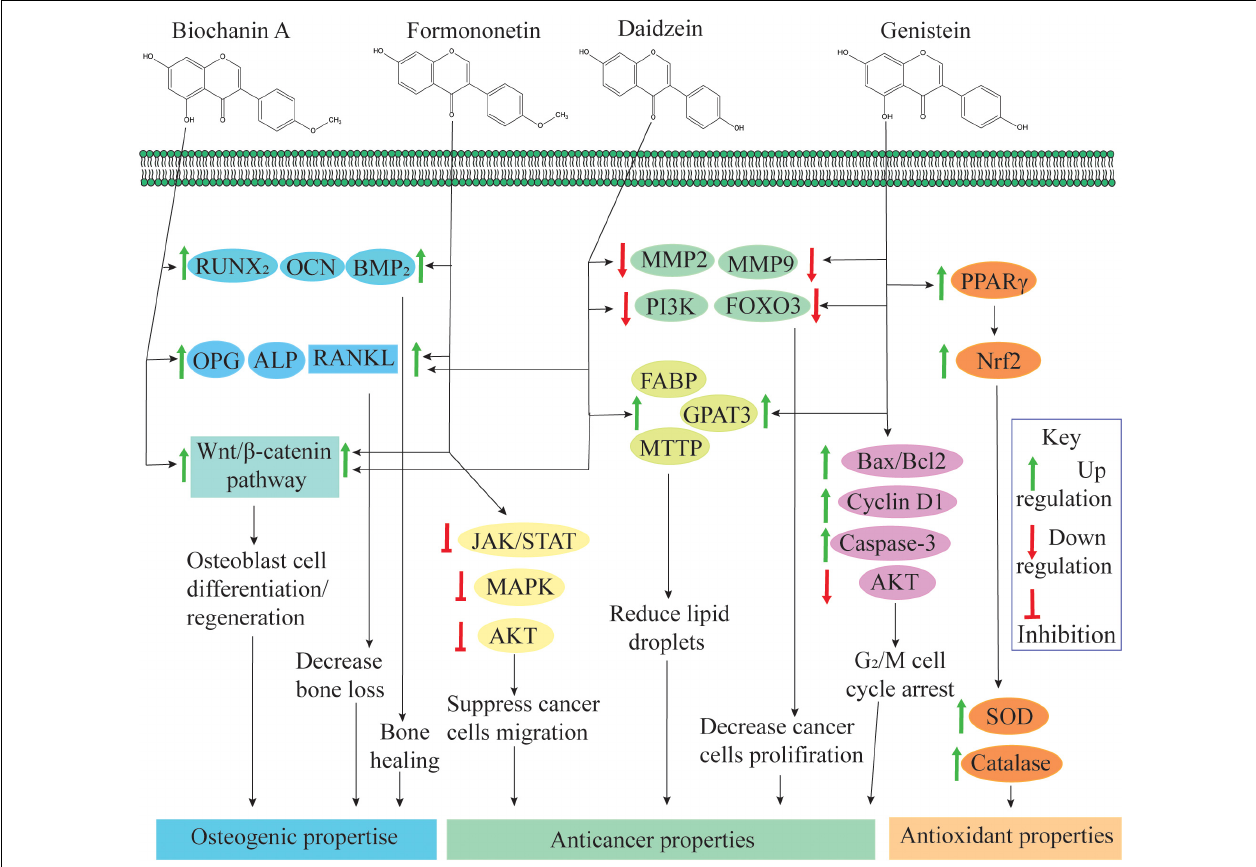
FIGURE 3 | Role of isoflavonoids in human health: biochanin-A and formononetin are involved in bone healing and regeneration effects by upregulating runt-related transcription factor 2 (RUNX2), osteocalcin (OCN) and bone morphogenetic protein 2 (BMP2) expression at the injury site (Singh et al., 2017). Biochanin-A, formononetin, and daidzein also regulate osteoprotegerin (OPG), alkaline phosphatase (ALP), and receptor activator of nuclear factor κβ ligand (RANKL) expression; and these compounds are actively involved in osteogenic activities (Zakłos-Szyda et al., 2020). Additionally, an isoflavone mixture (biochanin-A, formononetin, and daidzein) promotes osteoblast cell differentiation and proliferation through the activation of the Wnt/ β -catenin pathway (Chen et al., 2018). Additionally, formononetin inactivates signaling pathways, namely, Janus kinase/signal transducers, and activators of transcription (JAK/STAT) pathway, protein kinase B (PKB or AKT) pathway and mitogen-activated protein kinase (extracellular signal regulated kinase 1/2) [MAPK (ERK1/2)] pathways and suppresses cell migration, invasion and angiogenesis (Qi et al., 2016; Park et al., 2018). Daidzein and genistein can inhibit expression of matrix metalloproteinase-2/9 (MMP2/9), phosphatidylinositol-3-kinase (PI3K) and forkhead box O-3 (FOXO3) and reduce the cancer cell proliferation. Through activation of fatty acid-binding protein (FABP), glycerol-3-phosphate acyltransferase 3 (GPAT3) and microsomal triglyceride transfer protein (MTTP), genistein and daidzein reduce lipid droplet accumulation. Both of these situations induce apoptosis in cancer cells (as reviewed by Hsiao et al., 2020). Genistein activates the expression of Bcl-2-associated X-protein (Bax/Bcl-2), cyclin D1 and caspase-3 pathways and suppressed PI3K/AKT phosphorylation, which results in genistein-induced G2/M cell cycle arrest (Shafiee et al., 2016). Genistein activates